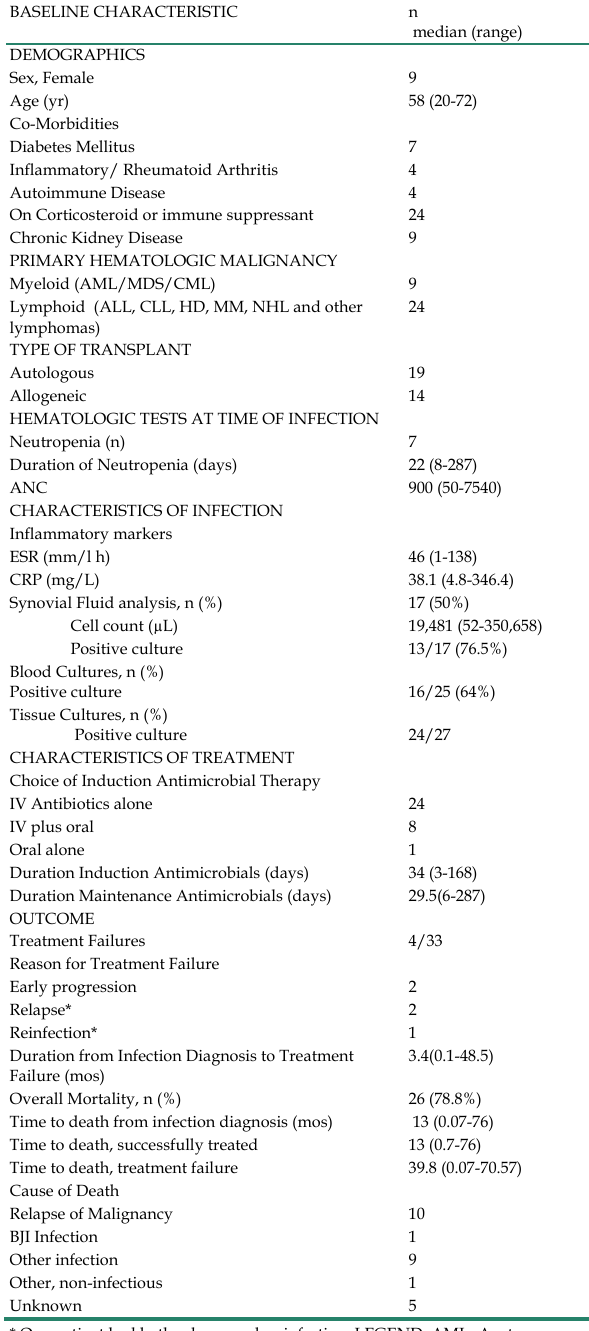
Table 1: Baseline Characteristics of Patients in the Study BASELINE